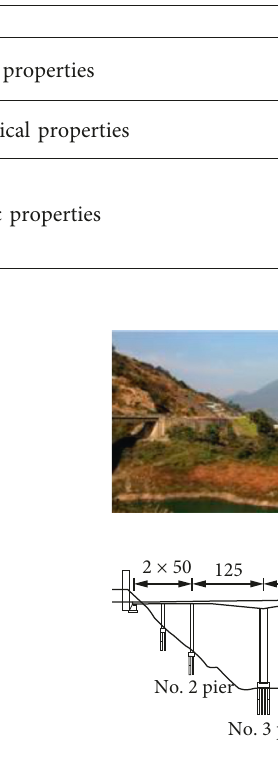
Table 1: Physical properties of the designed specimen.